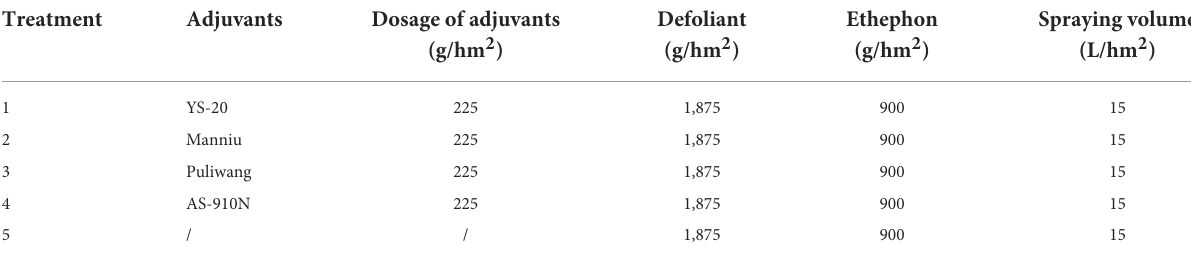
TABLE 1 Test treatment